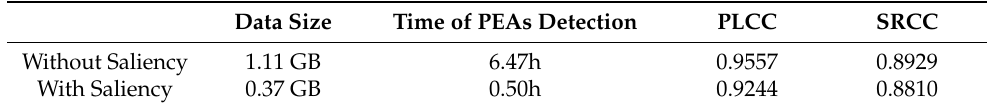
Table 5. Ablation experiments on the CSIQ VQD